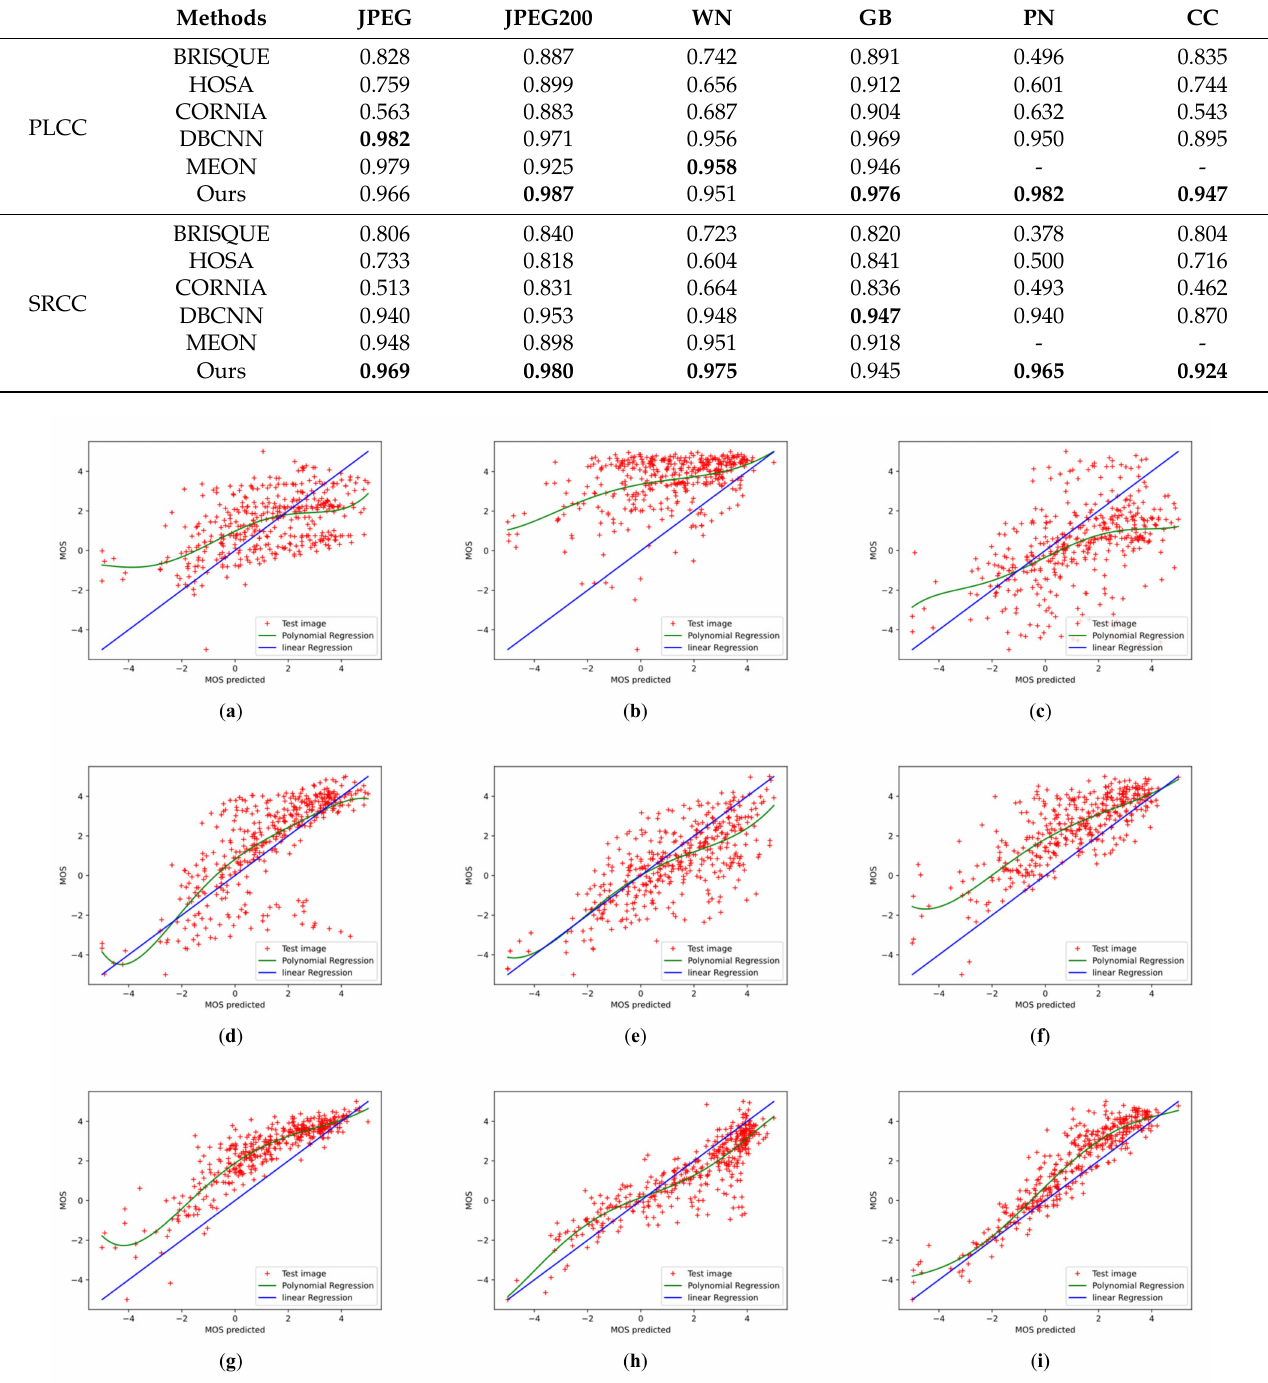
Figure 11. Scatter plots of ground-truth mean opinion scores (MOS) against predicted scores of ( a – f ) different IQA algorithms on CSIQ datasets. The red points denote the testing instances. The blue line is the ideal linear relationship between MOS and the prediction score. The green line is the curve fitted using the test instance. Higher correlation means better performance of the IQA